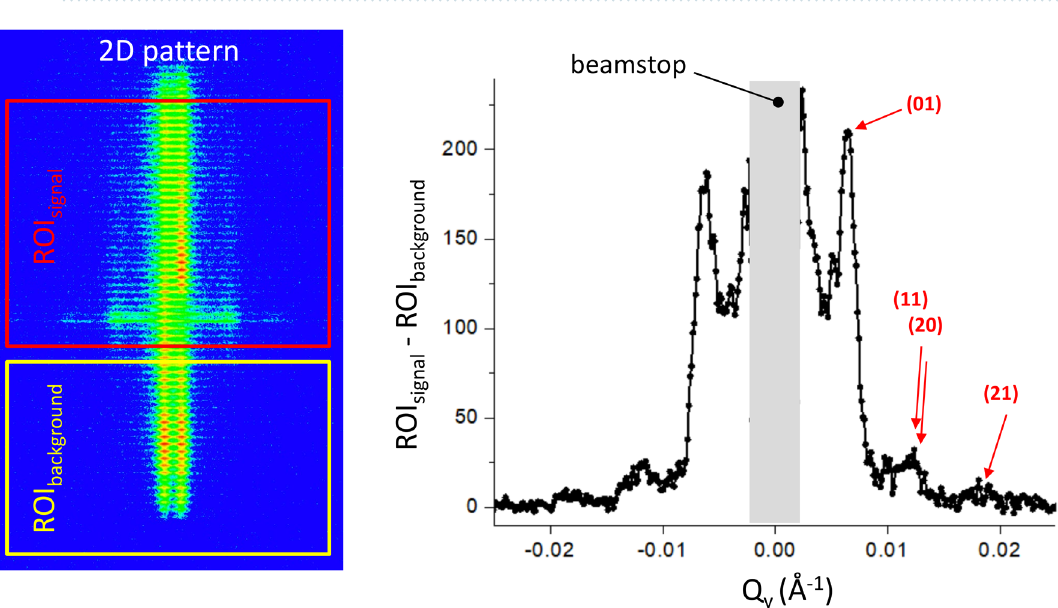
Figure 5. π-GISANS data taken on Super ADAM for 100 nm silica particles self-organised on a D 2 O surface. The panel to the left depicts the raw 2D-detector image with the regions of interest for the signal and background indicated. The panel to the right is the same data but vertically integrated over the respective regions of interest. The GISANS signal minus the background is plotted versus Q y on a linear